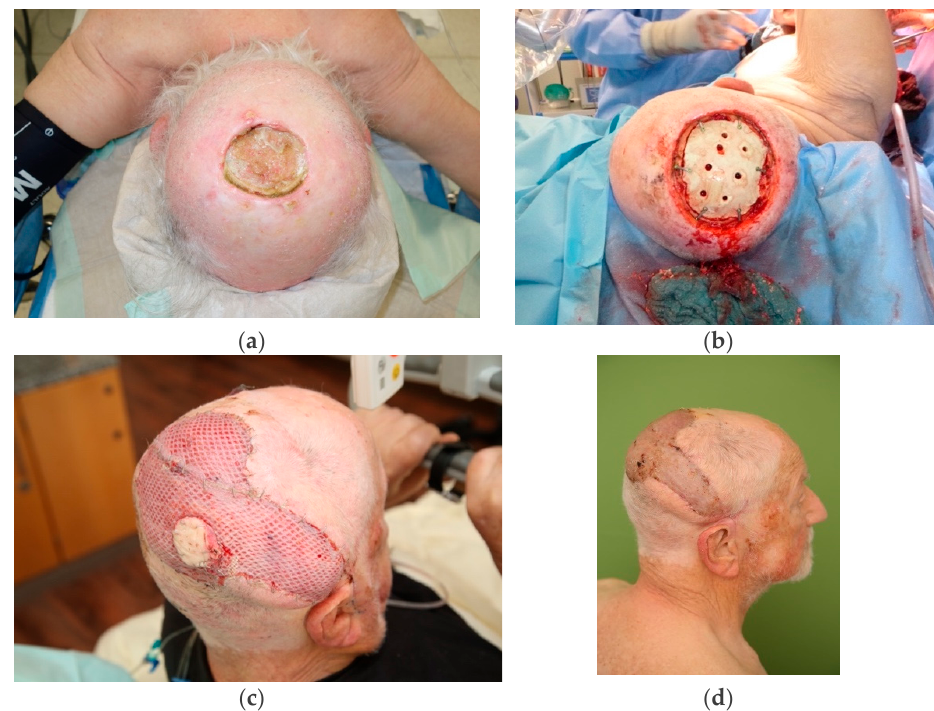
Figure 2. Microsurgical scalp reconstruction after resection of DUPS/AFX. Following an incomplete surgical resection and postoperative radiation of atypical fibroxanthoma on the scalp, this patient developed a local recurrence of DUPS/AFX 1 year after radiation therapy ( a ). The soft tissue and skull bone were resected with free margins in an interdisciplinary setting by neurosurgeons and reconstructive surgeons while the dura was preserved ( b ). The 9 × 10 cm bone ‐ and soft tissue defect was covered by use of Palacos bone cement ® followed by a free latissimus dorsi flap (end-to-end anastomosis to the right temporal artery) and split skin from the thigh for cover ( c ). A photo of the result at follow ‐ up at three months is displayed at the bottom right ( d ).